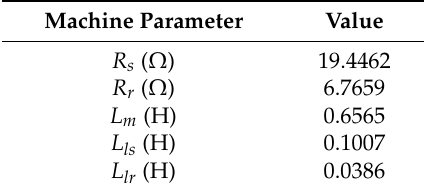
Table 4. Obtained parameters using the PSO algorithm.